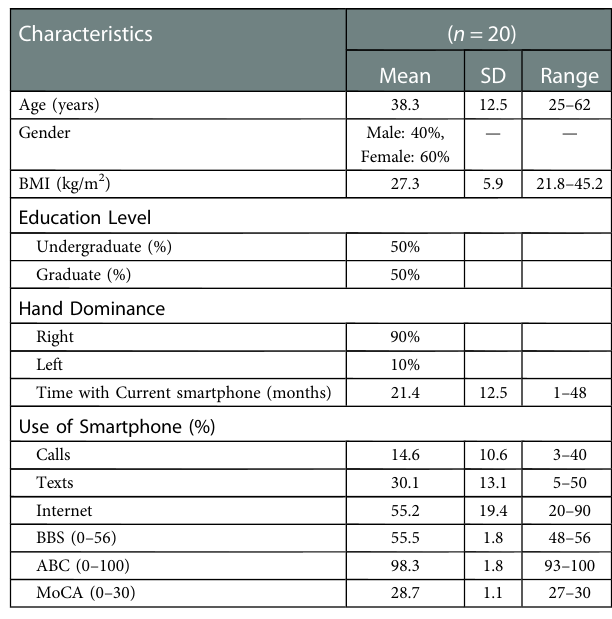
TABLE 1 Demographics and other basic assessment